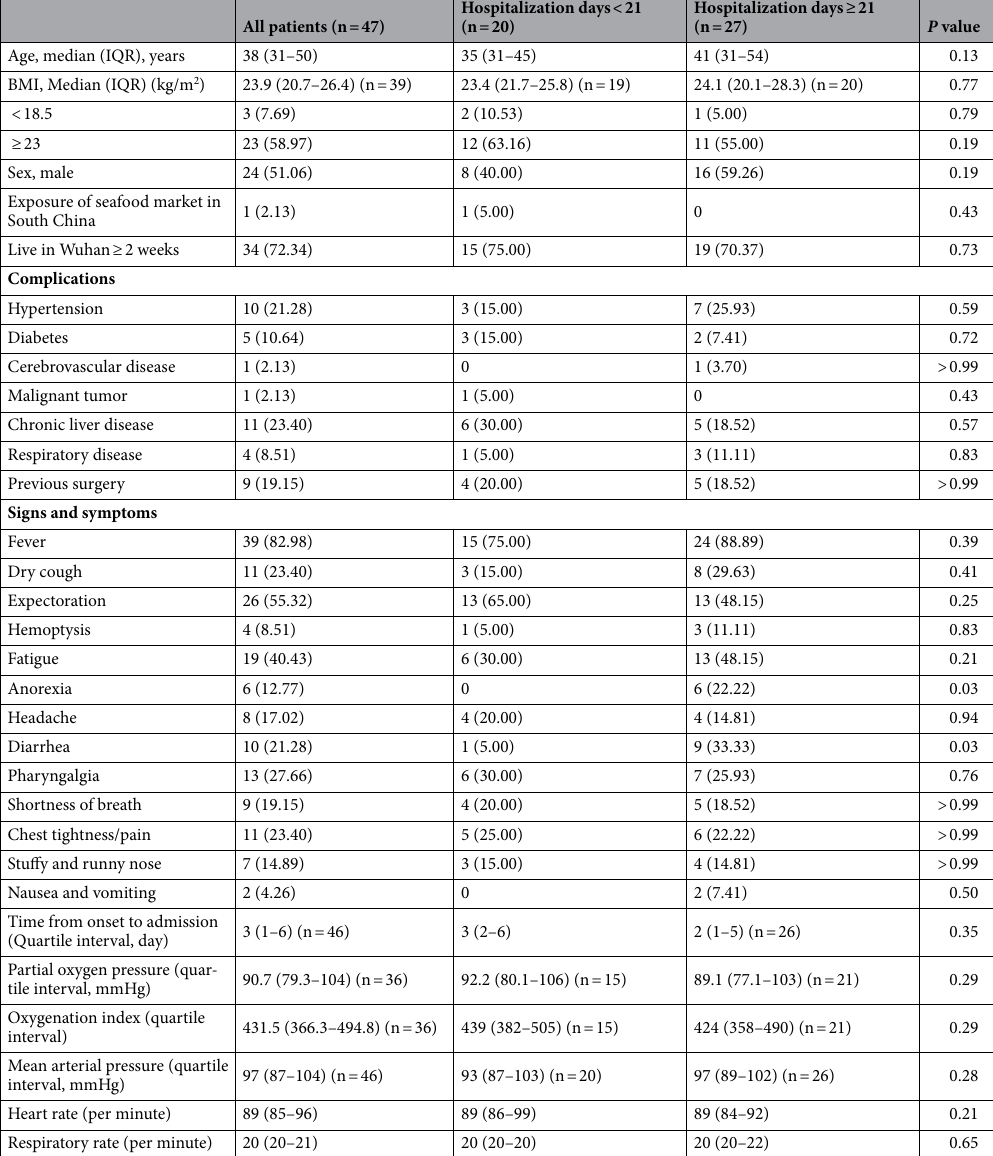
Table 1. Demographic and epidemiological characteristics of patients with COVID-19. Normal BMI (Asia standard): 18.5–22.9 kg/m 2 . BMI body mass index, IQR interquartile